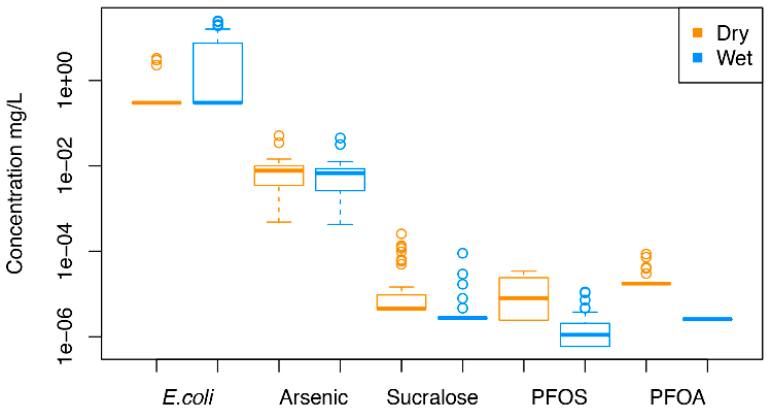
Figure 1. Contaminants that were significantly different by season, E.coli , sucralose, PFOS, and PFOA p -value ≤ 0.0001; arsenic p -value = 0.0004. PFOA: perfluorooctanoic acid; PFOS: perfluorooctane sulfate.